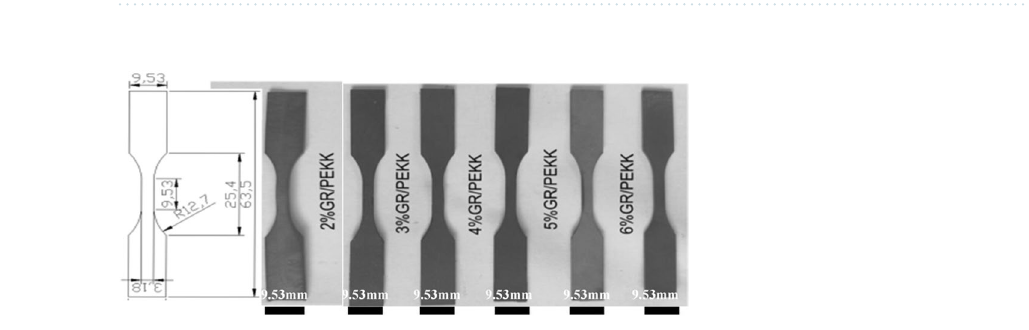
Figure 5. Sheets with diameter 80 mm and thickness 1.25 mm. ( a ) Graphene = 0%; ( b ) graphene = 2%; ( c ) graphene = 3%; (d) graphene = 4%; ( e ) graphene = 5%; ( f ) graphene = 6% (Visio 2021, Prof. WenPing. Song).